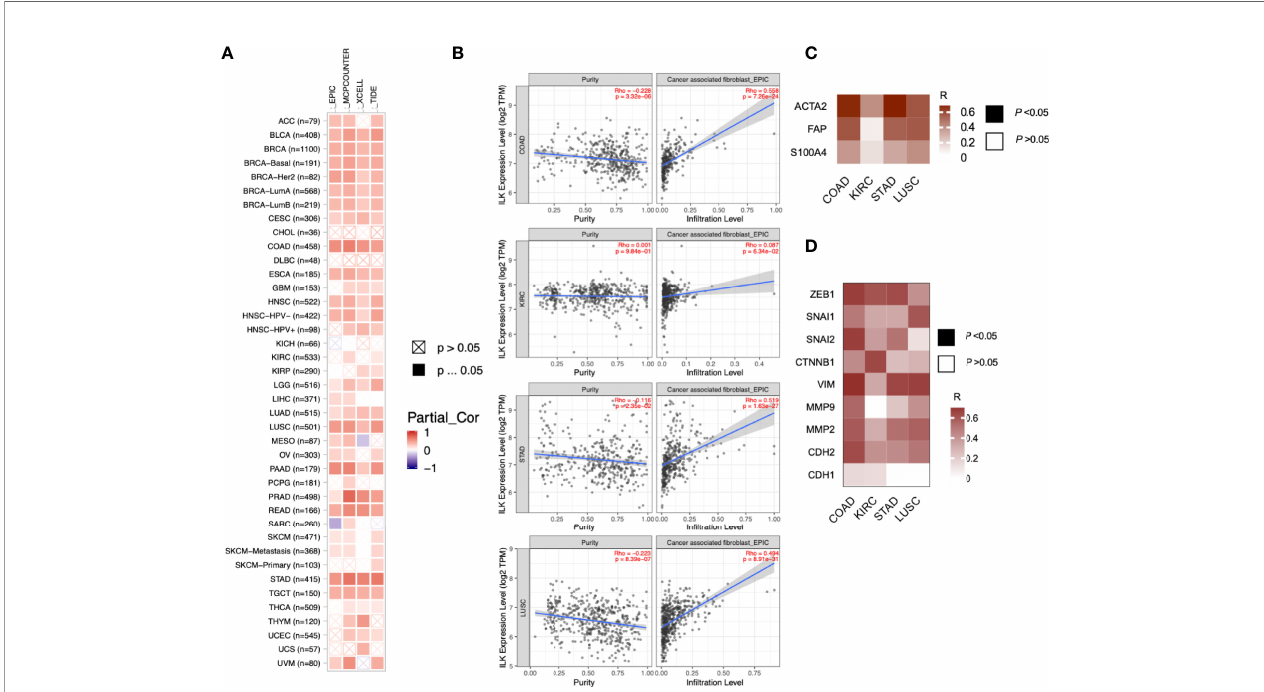
FIGURE 3 | ILK is correlated with CAF in fi ltration and EMT markers. (A) ILK expression is associated with CAF in fi ltration in most cancers as analyzed using TIMER. EPIC, MCPCOUNTER, XCELL and TIDE as shown in the heat map are different methods for cell quanti fi cation based on gene expression. Since most fi broblasts and immune cells are negatively correlated with tumor purity, the correlation is adjusted by purity (referred as Partial_Cor) partial spearman ’ s correlation rho. (B) The ILK expression is correlated with CAFs in fi ltration in COAD, KIRC, STAD and LUSC via TIMER. (C) Heat map showing the correlation in expression between ILK and key gene markers for CAFs in COAD, KIRC, STAD and LUSC tumors via GEPIA. (D) Heat map showing the correlation in expression between ILK and different gene markers for EMT in COAD, KIRC, STAD and LUSC tumors via GEPIA. The values in the heat map are for Spearman ’ s correlation Rho, R. The scale on the right of the heat map is for R values. All colored squares are statistically signi fi cant whereas white squares are not statistically signi fi cant. The R values above 0.08 are statistically signi fi cant. Signi fi cant P -value is <